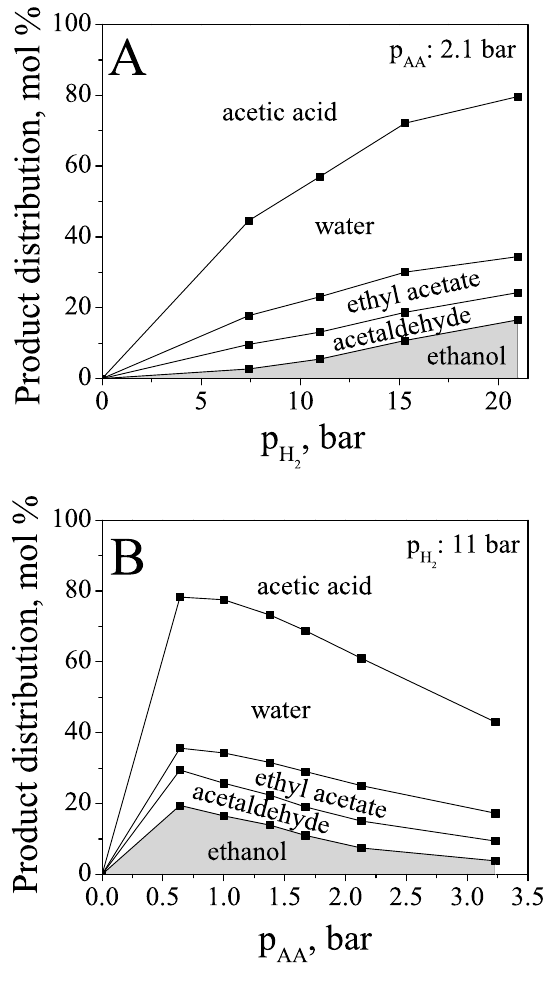
Figure 6 : Stacked area graphs of AA hydroconversion as a function of hydrogen and acetic acid partial pressures at 340°C over NiIn/ Sylobead